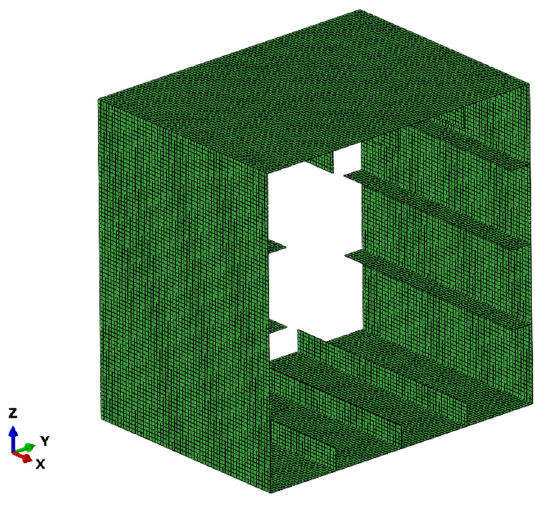
Figure 5. Mesh density of one span in the